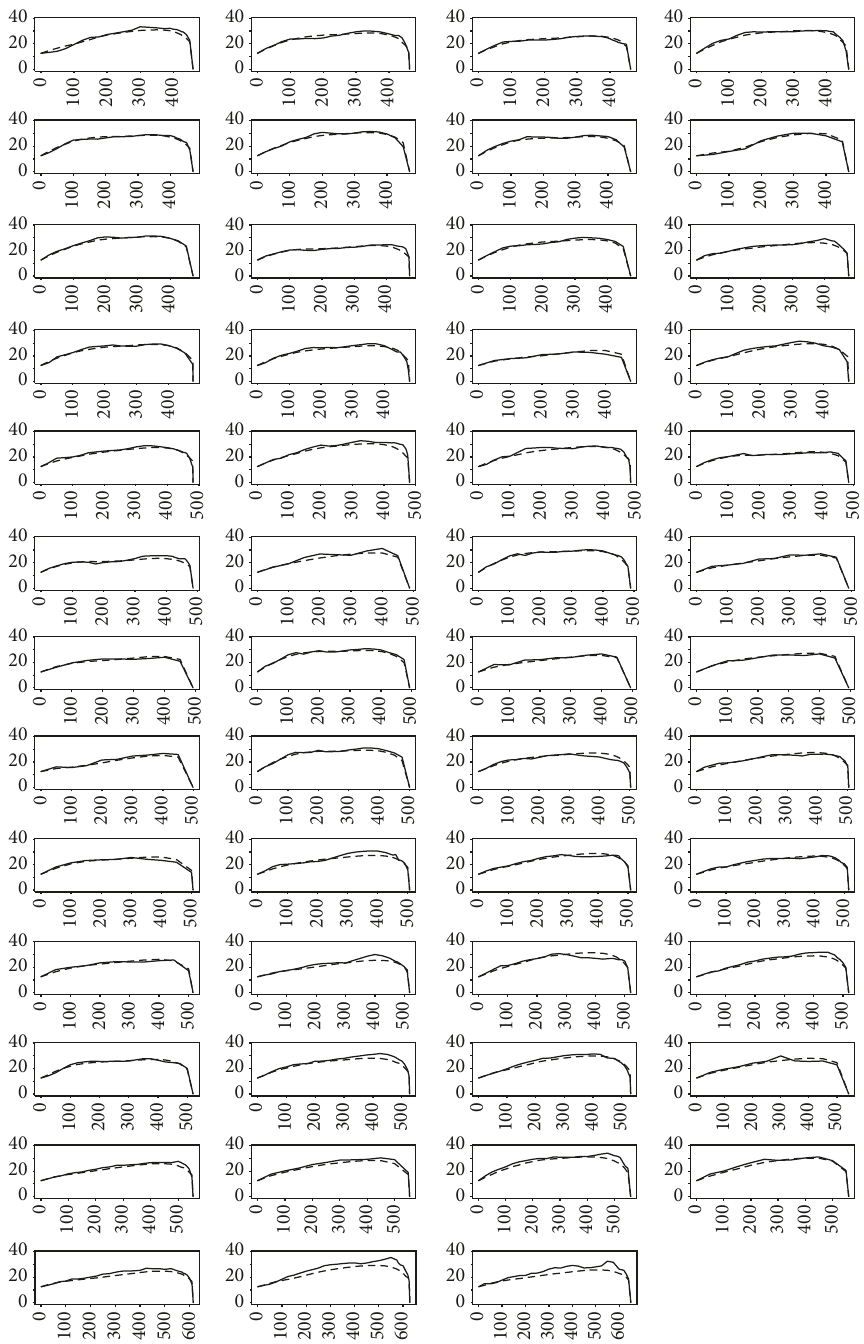
WA; the MSE was 15.71 for S-RM at 𝑥 = 235.0 mm and 11.48 for M-RM at 𝑥 1 = 255.0 mm and 𝑥 2 = 105.0 mm.